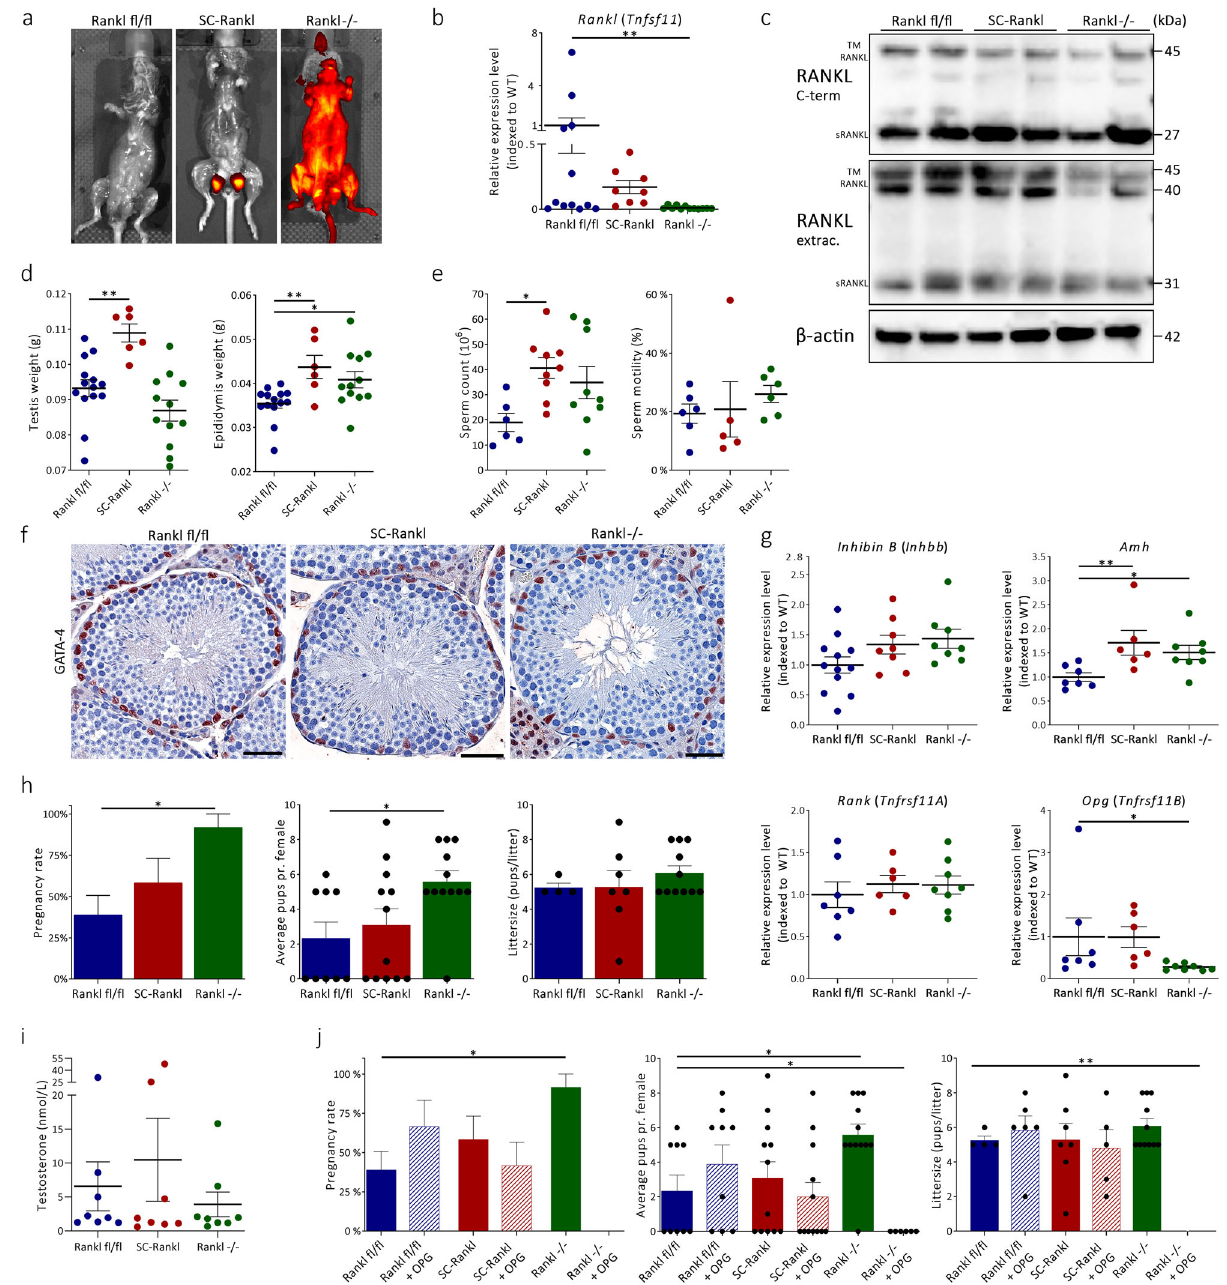
Fig. 2 Phenotypic effects of systemic versus Sertoli cell-speci fi c suppression of RANKL. a Rosa reporter expression in Rankl fl / fl , Sertoli speci fi c (AMHCre;Rankl fl / fl , SC- Rankl ), and global (VasaCre;Rankl fl / fl , Rankl − / − ) RANKL-de fi cient mice. b , c Expression of RANKL at mRNA and protein level in Rankl fl / fl (blue), SC- Rankl (red), and Rankl − / − (green) mice ( b , fl / fl vs. SC: p = 0.923, fl / fl vs. − / − : p = 0.004). d Testicular and epididymal weight of Rankl fl / fl , SC- Rankl , and Rankl − / − mice, (left panel; p = 0.003, p = 0.159, right panel; p = 0.008, p = 0.033). e Sperm count and ABC sperm motility of Rankl fl / fl , SC- Rankl , and Rankl − / − mice, (left panel; p = 0.013, p = 0.107). f Morphology and expression of Sertoli cell marker GATA-4 in testis of Rankl fl / fl , SC- Rankl , and Rankl − / − mice. Counterstaining with Mayer ’ s hematoxylin. Scale bars correspond to 50 μ m. g Gene expression of Inhibin B , Amh , Rank , and Opg in Rankl fl / fl , SC- Rankl , and Rankl − / − mice, (top right panel; p = 0.01, p = 0.02, bottom right panel; p = 0.07, p = 0.04). h Fertility study of Rankl fl / fl , SC- Rankl , and Rankl − / − male mice exposed to three healthy females for 5 days, (left panel; p = 0.02, middle panel; p = 0.01). i Serum testosterone (nmol/L) in Rankl fl / fl , SC- Rankl , and Rankl − / − mice. j Fertility study of Rankl fl / fl , SC- Rankl , and Rankl − / − mice after OPG treatment (1 mg/kg x 2 weekly for 2 weeks), (left panel; p = 0.02, middle panel; p = 0.02, p = 0.01, right panel; p = 0.005). The OPG-treated Rankl − / − mice did not give birth to pups. Note, y -axes do not intersect x -axes at 0 ( d ). Data are presented individually and as mean ± SEM, with n ( Rankl fl / fl / SC-Rankl / Rankl − / − ) = 12/ 8/12 ( b ), n ( = 14/6/12 ( d ), n = 6/9/9 (left panel, e ), n = 6/5/6 (right panel, e ), n = 4 – 6 ( f ), n = 12/8/8 (top left panel, g ), n = 7/6/8 (top right, bottom left and right panels, g ), n (male/female) = 6/18 ( Rankl fl / fl ) and n = 4/12 (SC- Rankl ) and n = 4/12 ( Rankl − / − ) for all panels ( h ), n = 8 ( i ), n (male/ female) = 3/9 ( Rankl fl / fl + OPG) and n = 4/12 (SC- Rankl + OPG) and n = 2/6 ( Rankl − / − + OPG) ( j ). Statistical tests: one-way analysis of variance (ANOVA) with Dunnett ’ s test to adjust for multiple comparisons ( b , d , e , g , h (middle panel), j (middle and right panels)) or Pearson chi square test ( h (left panel), j (left panel)) with * p < 0.05, ** p <